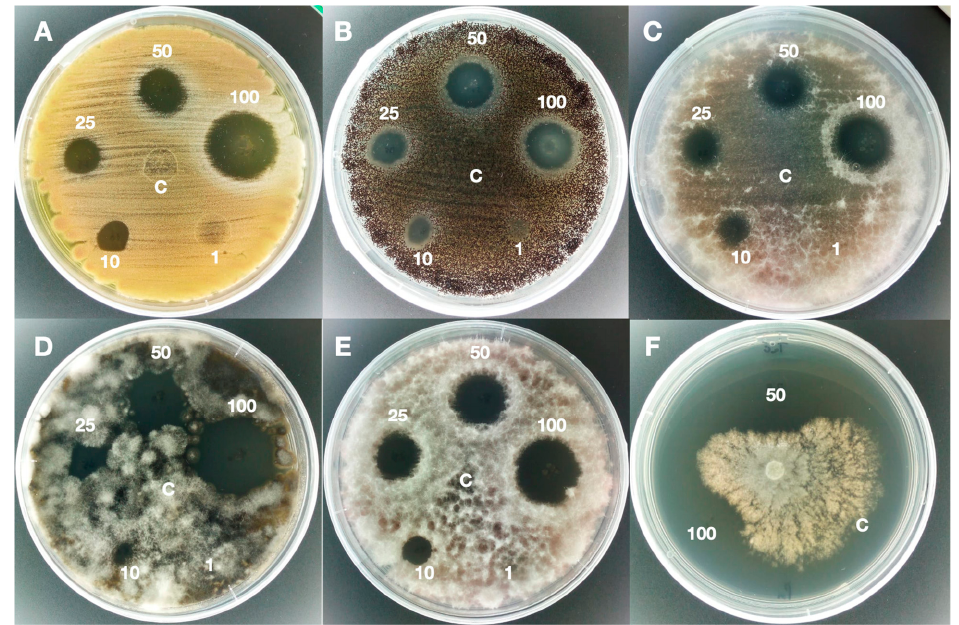
Figure 1. Agar diffusion test of Trichoderma asperellum IMI393899 extract. The picture shows the halos of antifungal activity at different concentrations (1, 10, 25, 50, and 100 mg/mL) of 30-days EtOAc extract and in comparison with the "C" control (10% DMSO) on Penicillium camemberti ( A ), Aspergillus carbonarius ( B ), Fusarium verticillioides ( C ), Neofusicoccum parvum ( D ), Colletotrichum acutatum ( E ), and Phytophthora nicotianae ( F ). J. Fungi 2020 , 6 , x FOR PEER REVIEW